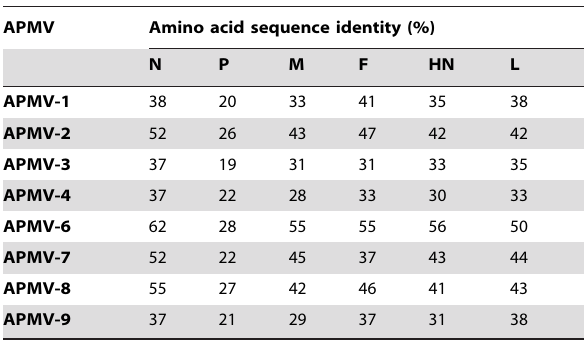
Table 5. Percent amino acid sequence identities between the proteins of APMV-5 strain Kunitachi and those of prototype strains of the other APMV serotypes.